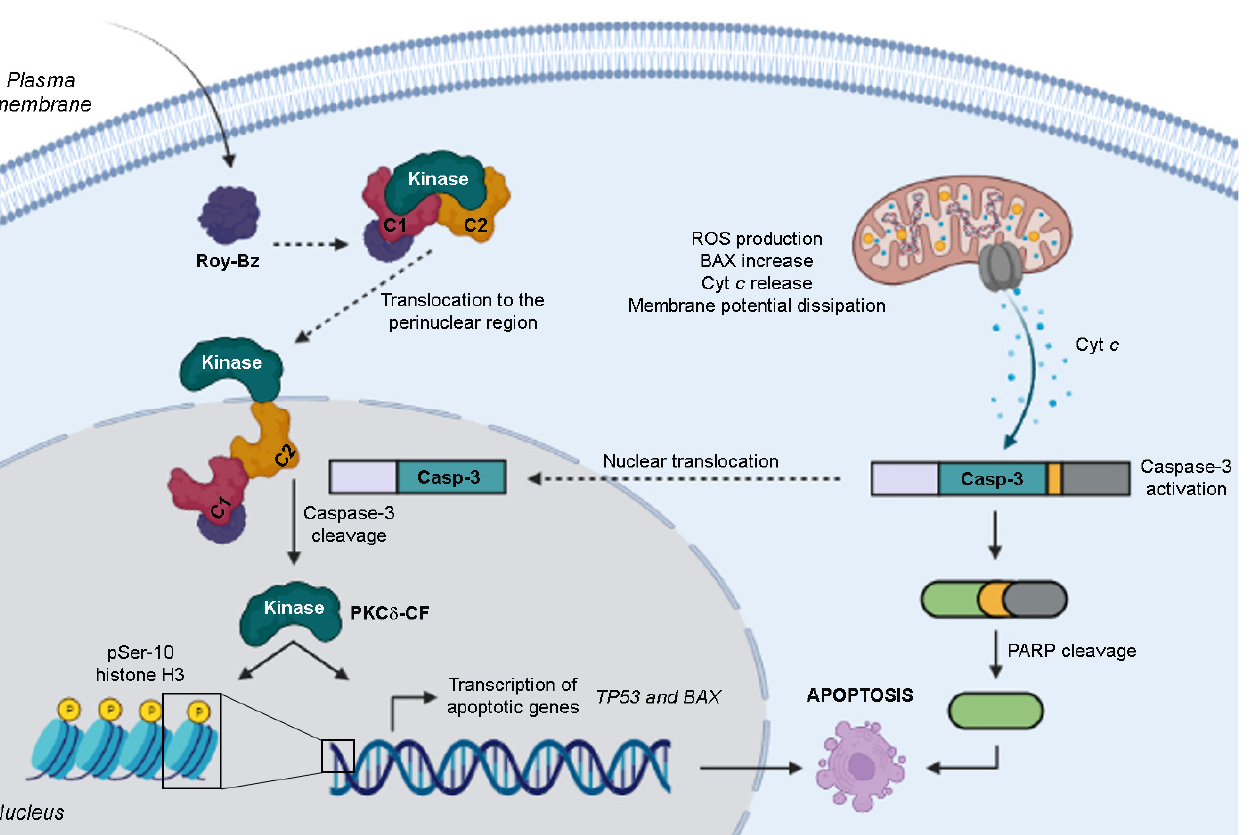
Figure 1. Schematic representation of the molecular mechanism of action of Roy-Bz-induced apoptosis. Roy-Bz binds to the PKC δ -C1 domain, inducing its translocation to the perinuclear region. In the nucleus, PKC δ is cleaved by caspase-3, resulting in the generation of the PKC δ catalytic fragment (PKC δ -CF), which in turns phosphorylates nuclear substrates, such as histone H3 on Ser-10, that promotes apoptosis. Additionally, it triggers the transcription of apoptotic genes, namely TP53 and BAX , thus promoting a mitochondrial apoptotic pathway, with subsequent cytochrome c (cyt c ) release, activation of caspase-3, PARP cleavage, and ultimately apoptosis induction.